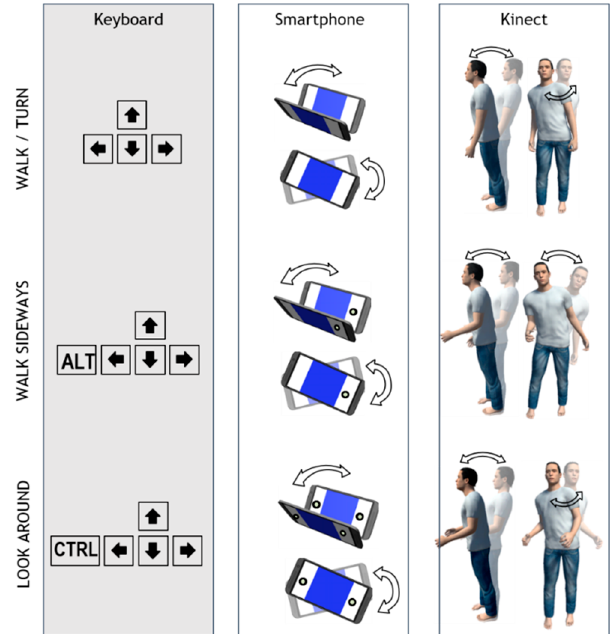
Figure 1. The interaction techniques for the three input modalities (keyboard, Kinect, smartphone) regarding the respective navigation modes (walk/turn, walk sideways, look around).